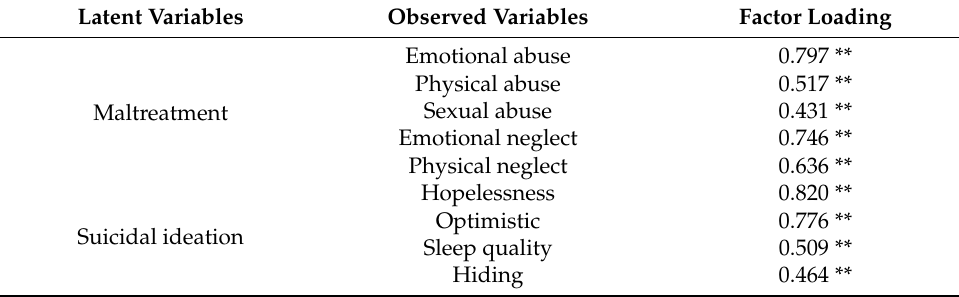
Table 3. Results of measurement model.